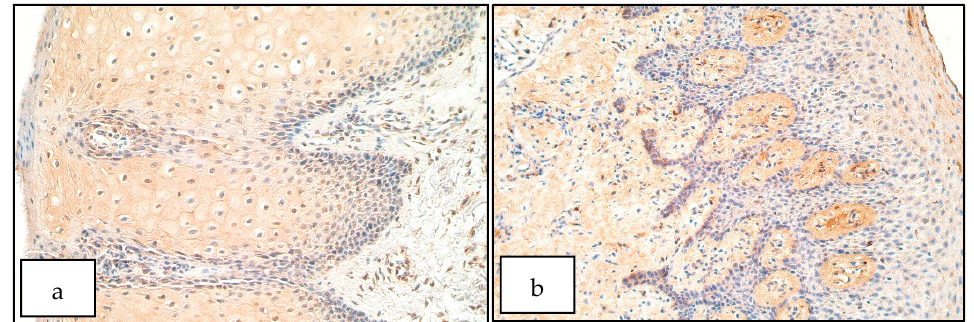
Figure 5. Immunoreactive structures for PAX7. ( a ) Few to moderate PAX7 positive structures in the patient epithelium, moderate PAX7 positive structures in the patient connective tissue, PAX7 IHM, 200×. ( b ) Few to moderate PAX7 positive structures in control group epithelium, moderate positive structures in control connective tissue, PAX7 IHM, 200×.